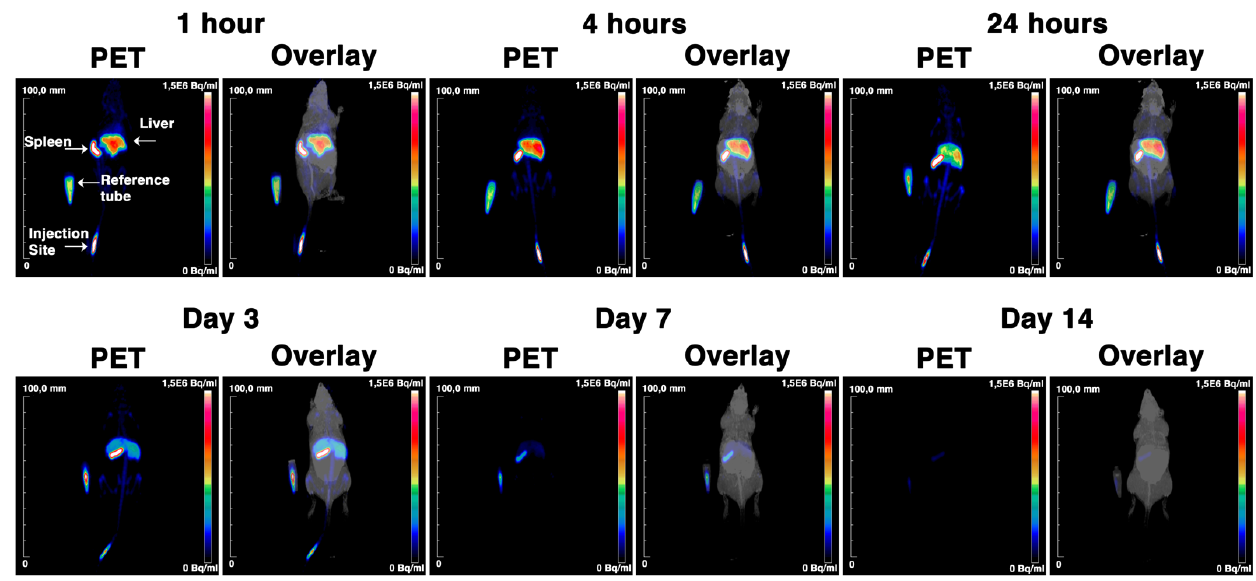
Figure 3. PET/MRI images of [ 89 Zr]Zr-PLGA-NH 2 NPs in C57BL/6 mice. C57BL/6JRj mice were intravenously injected with [ 89 Zr]Zr-PLGA-NH 2 NPs and imaged with PET/MRI at 1 h, 4 h, 24 h, 3 days, 7 days and 14 days post-injection. The reference tube contains 10% of the injected 89 Zr dose.